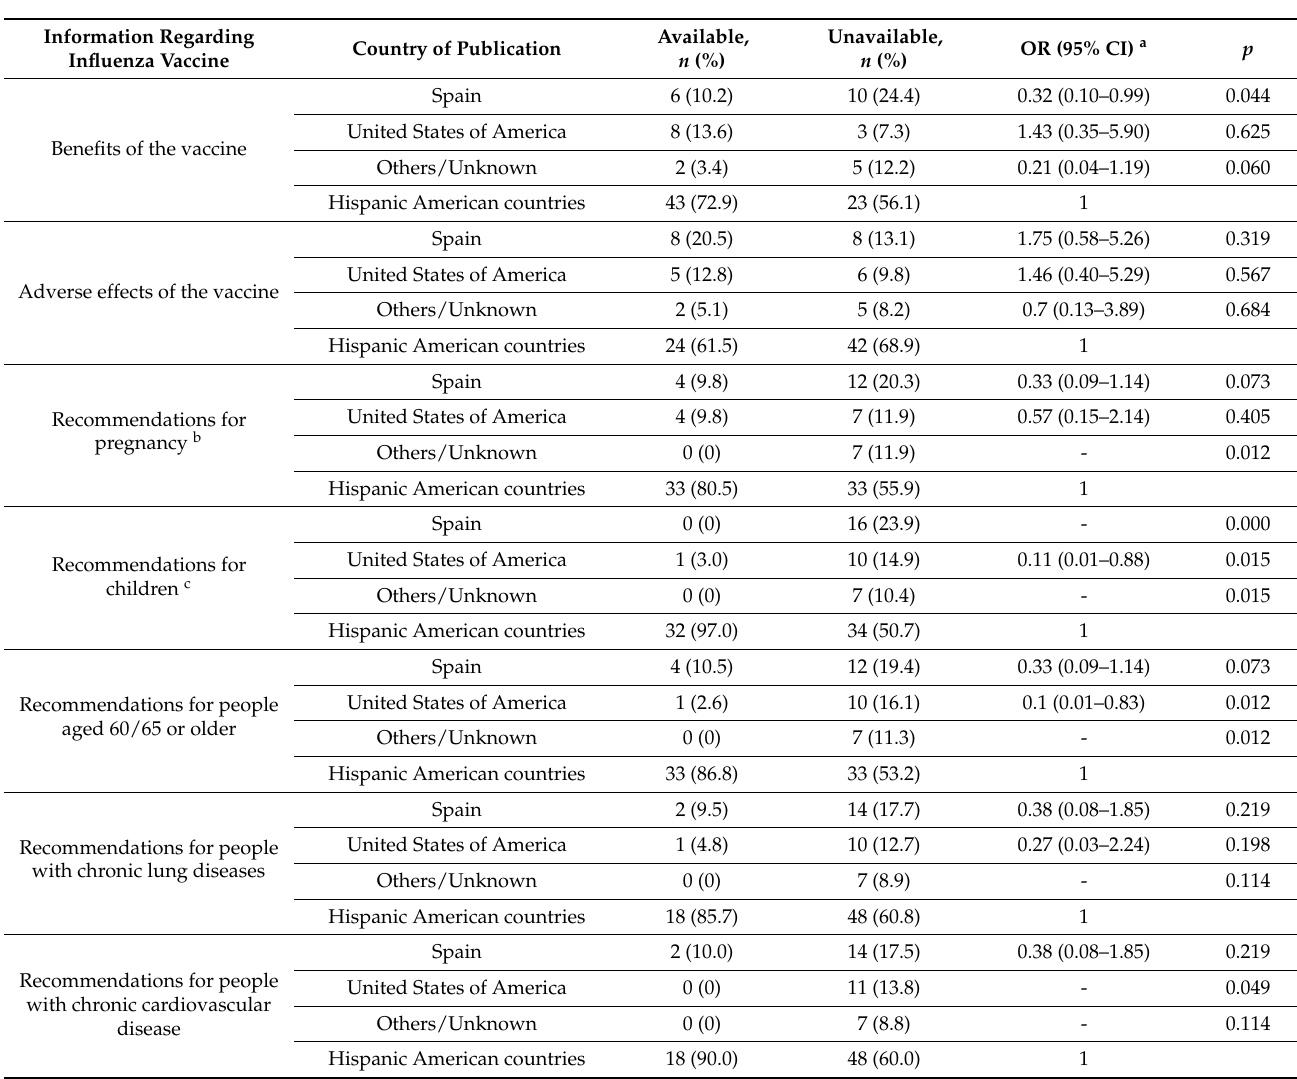
Table 8. Country of publication and information discussed regarding the influenza